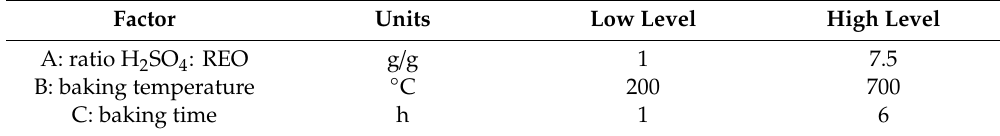
Table 3. Factors and chosen levels of the digestion for the design of experiment. Factor Units Low Level High